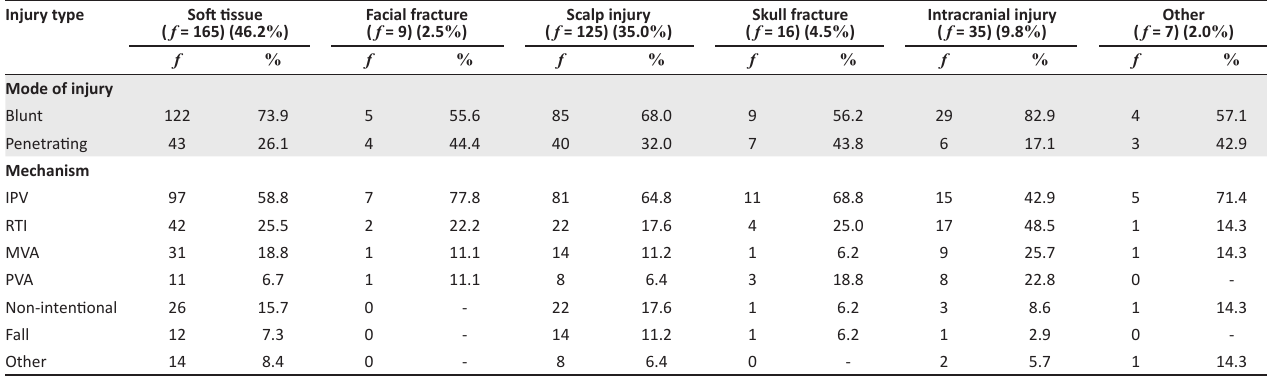
TABLE 2: Contributions of modes and mechanisms to different injury types ( n = 263) . Injury type